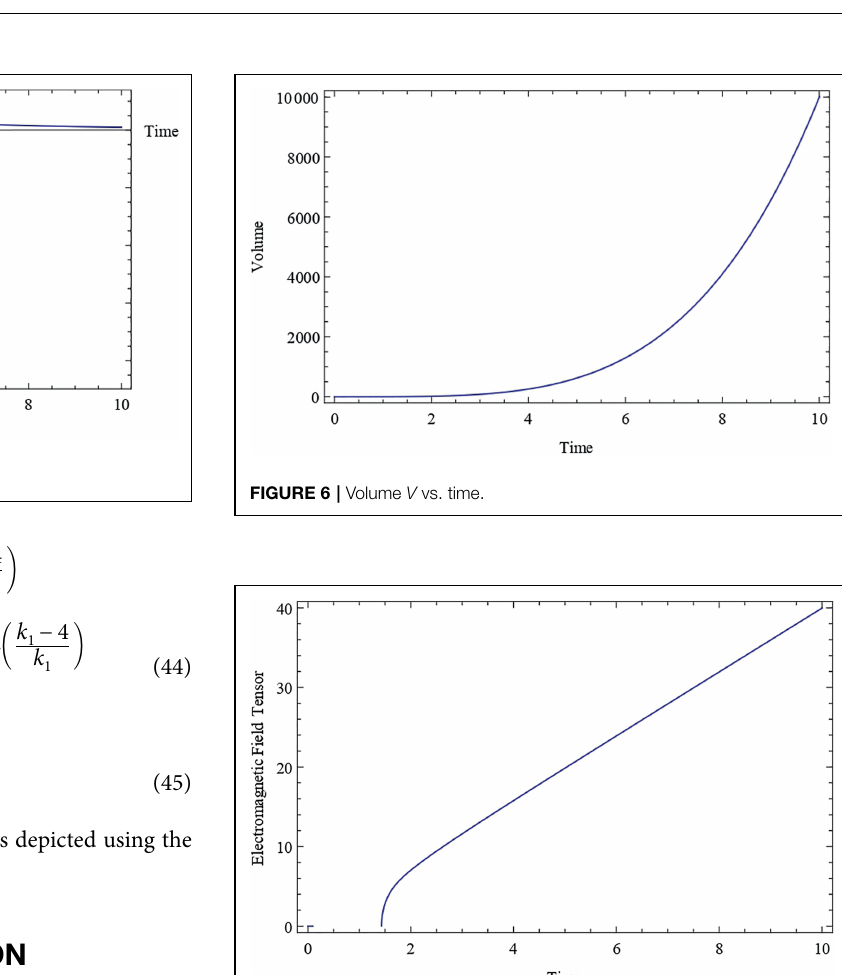
FIGURE 4 | Energy density ρ vs. time.